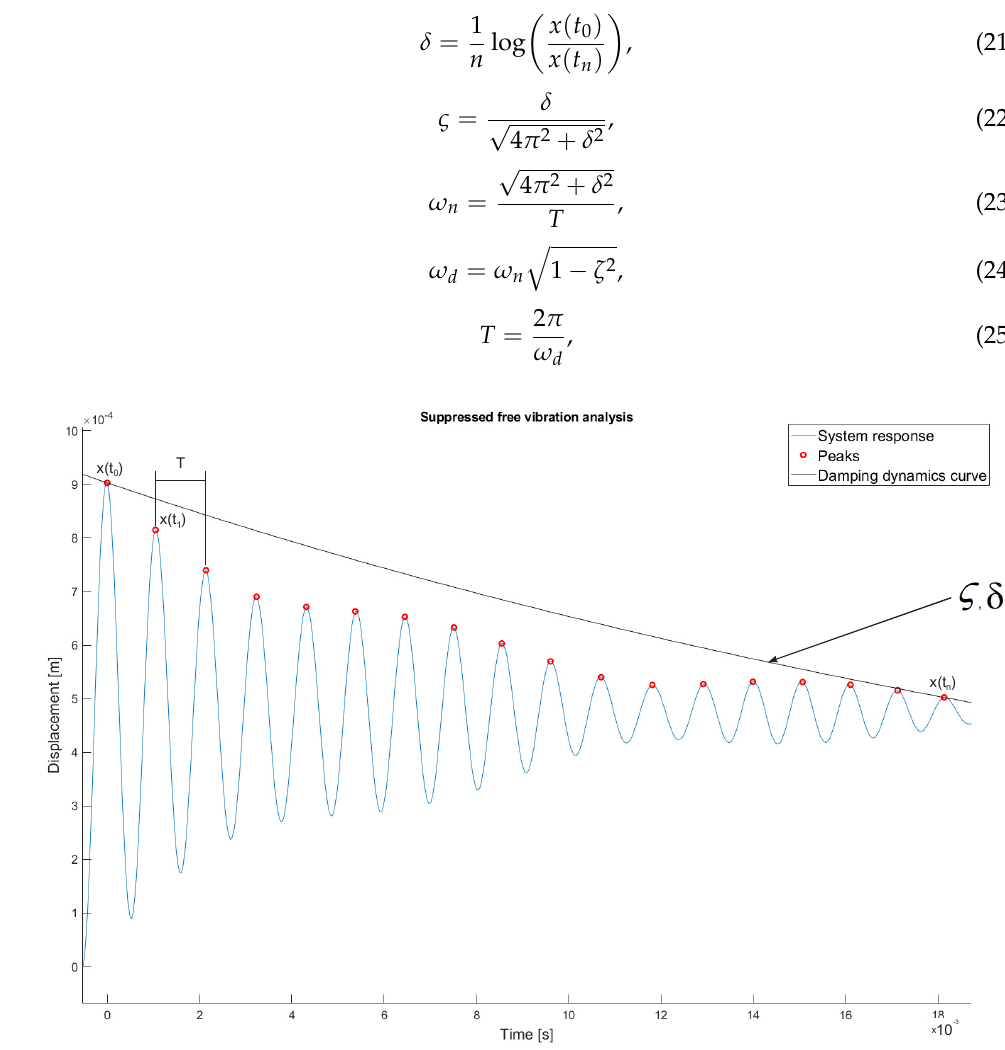
Figure 7. Summary of the recorded response of the system (blue line) with marked peaks of individual amplitudes (red markers) and the damping dynamics curve (black line).